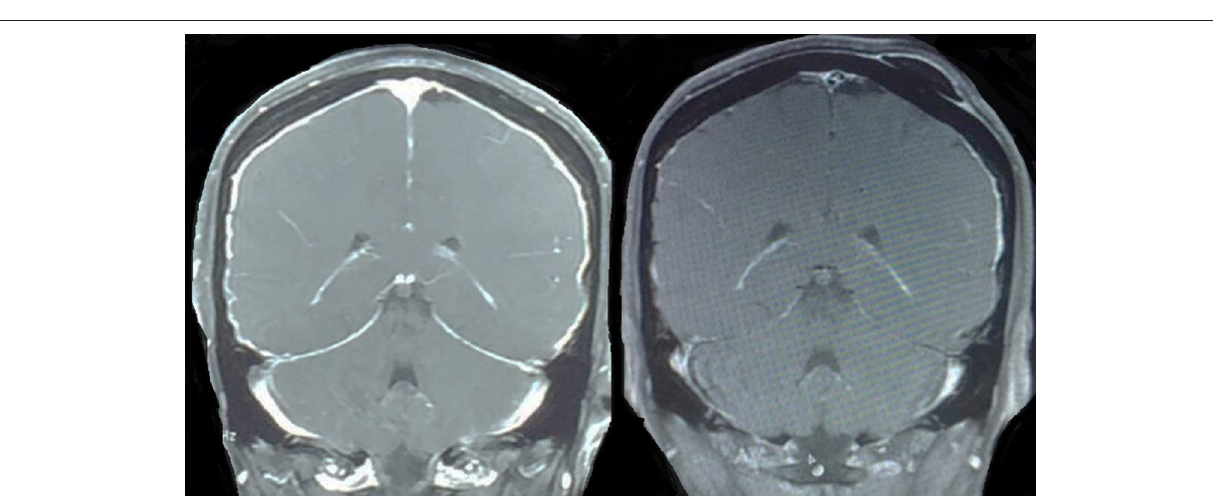
FIGURE 4 | 45 yr old female patient with diagnosis of breast cancer and leptomeningeal disease with complete radiological response after treatment with Mtx/Ara-C by Ommaya